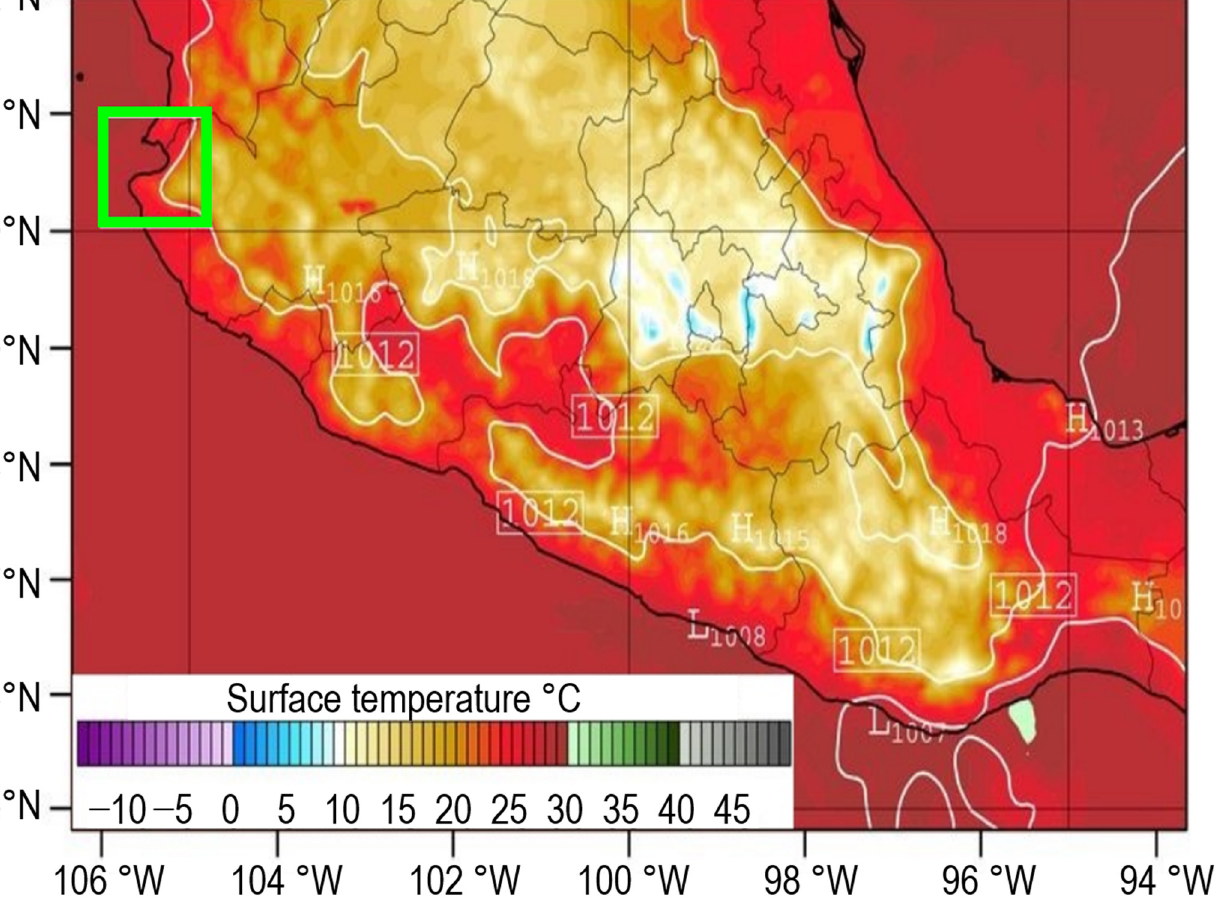
Figure 2. Central area of Mexico that shows the nesting of WRF model used in the Centro de Cien- cias de la Atmósfera at UNAM. The green box indicated the validation area (BB region). This image corresponds to the 06:00 UTC forecast (1 September 2010).